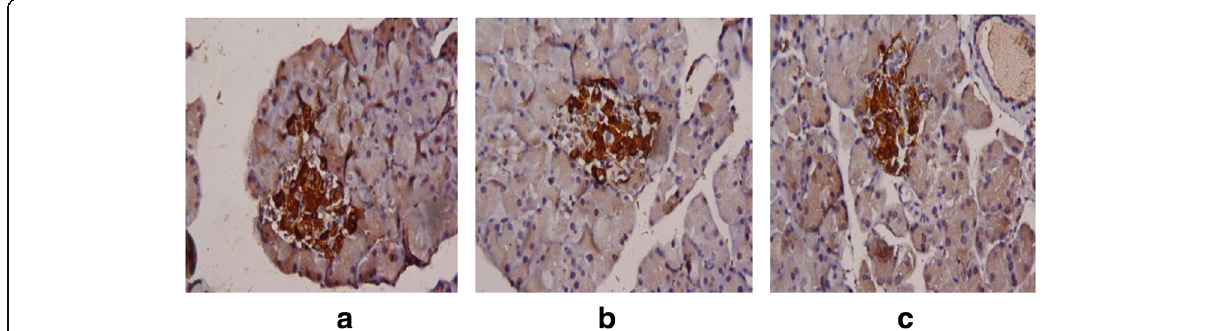
Fig. 4 Immunohistochemical graphs showing a negative control which shows marked immunohistochemical insulin positive reaction. b Diabetic model induced with STZ shows mild immunohistochemical insuline positivity distributed in the islets. c STZ-induced diabetic model treated with curcumin extract shows marked immunohistochemical insulin